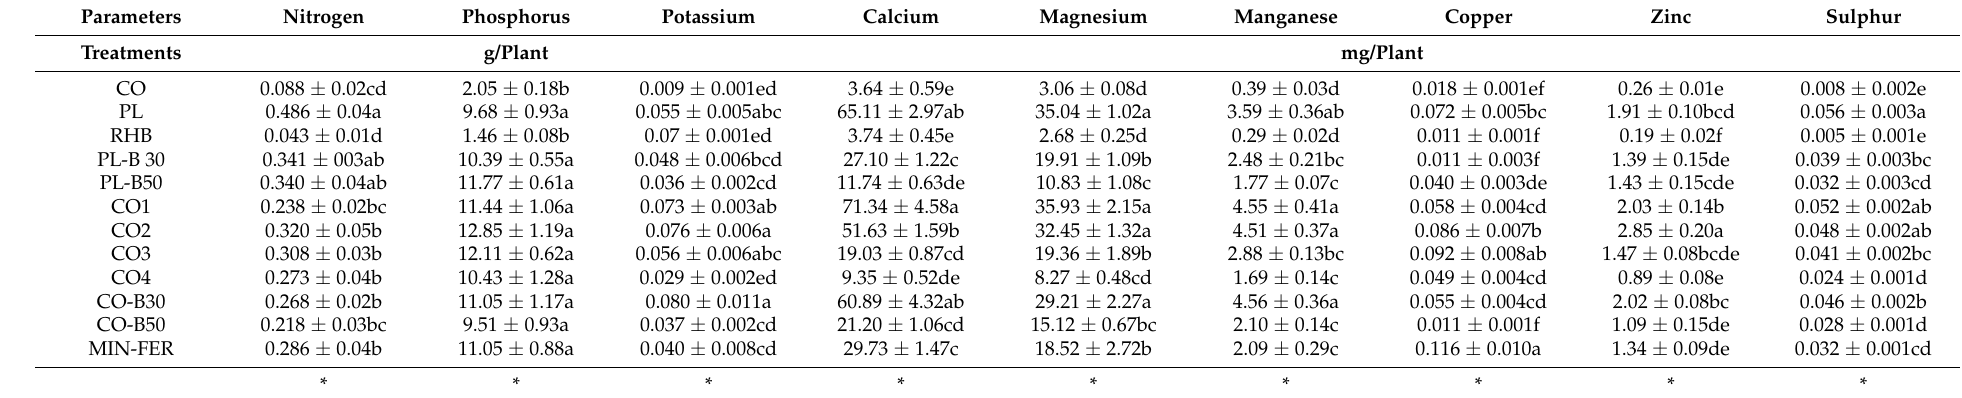
Table 6. Table of mean plant nutrient uptake by maize at 50